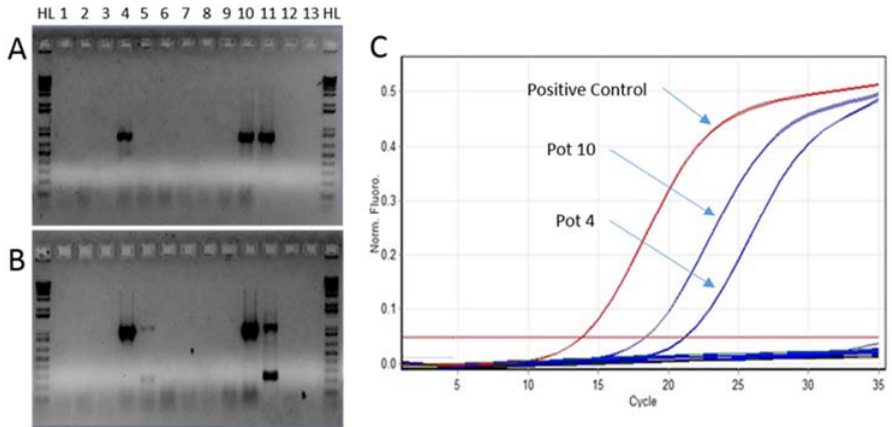
Figure 1. Conventional RT-PCR of the CGMMV coat protein ( A ), movement protein ( B ) and RT- qPCR ( C ) of positive CGMMV detections in soil longevity (18 month) screenhouse trials of IP4 (Lane 1–10 = pots 1–10; Lane 11 = positive control; Lane 12 and 13 = negative controls).